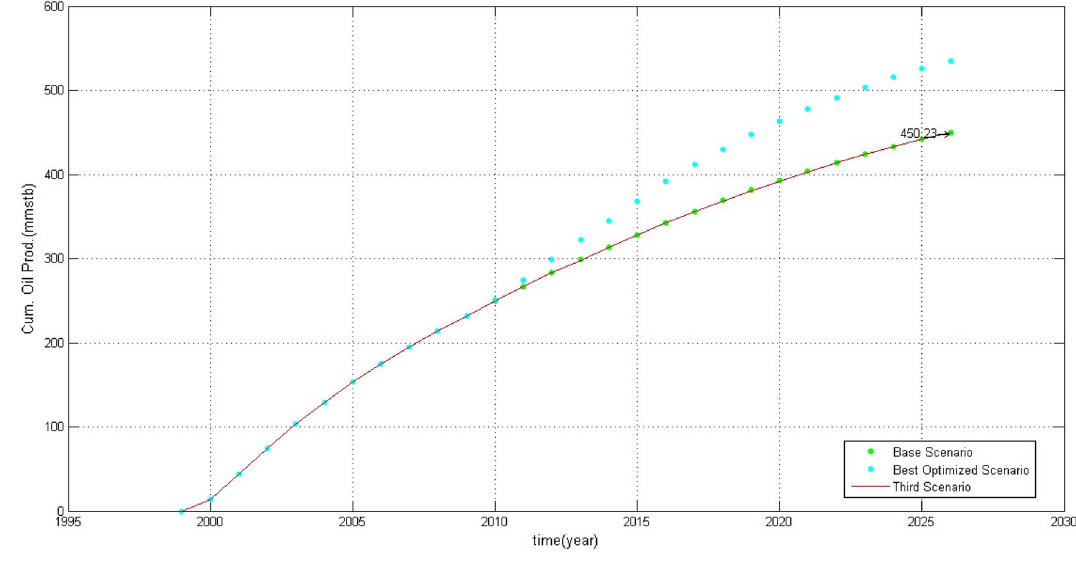
Fig. 6 Cumulative oil production of third scenario